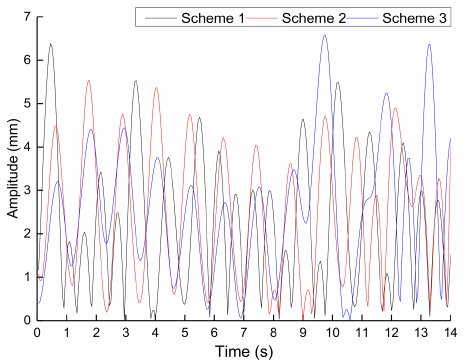
Figure 12. Amplitude change when h = 30 cm.